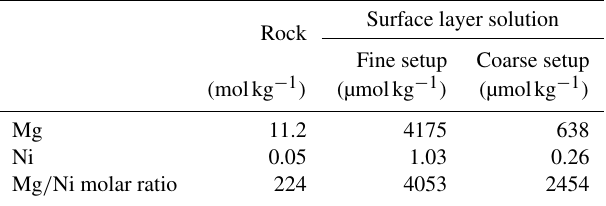
Table 4. Preferential release of Mg over Ni into pore water solution during the dissolution of dunite. Molar ratios of Mg / Ni in the dunite are based on XRF analysis. Surface layer solution values for fine and coarse setups are averaged over the experimental